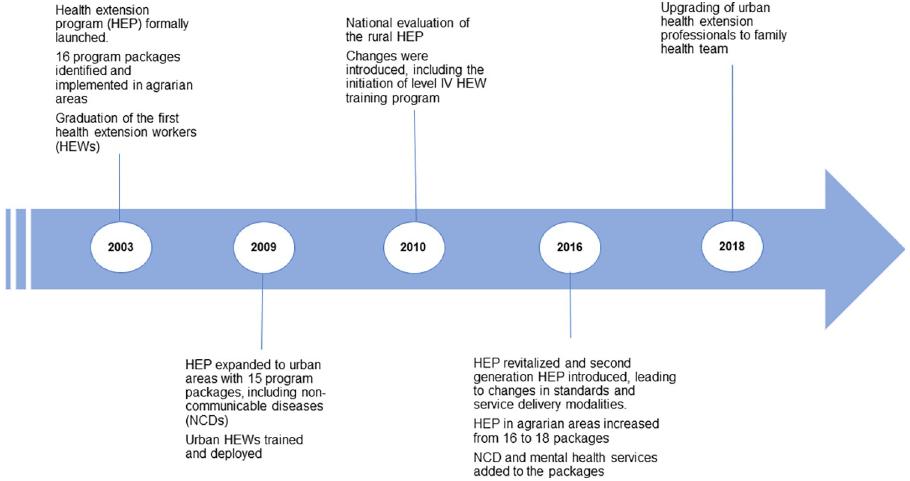
Fig 1. Major HEP and Ethiopian health system development timeline. Source: Ethiopia Federal Ministry of Health roadmap for optimizing the Ethiopian health extension program 2020–2035